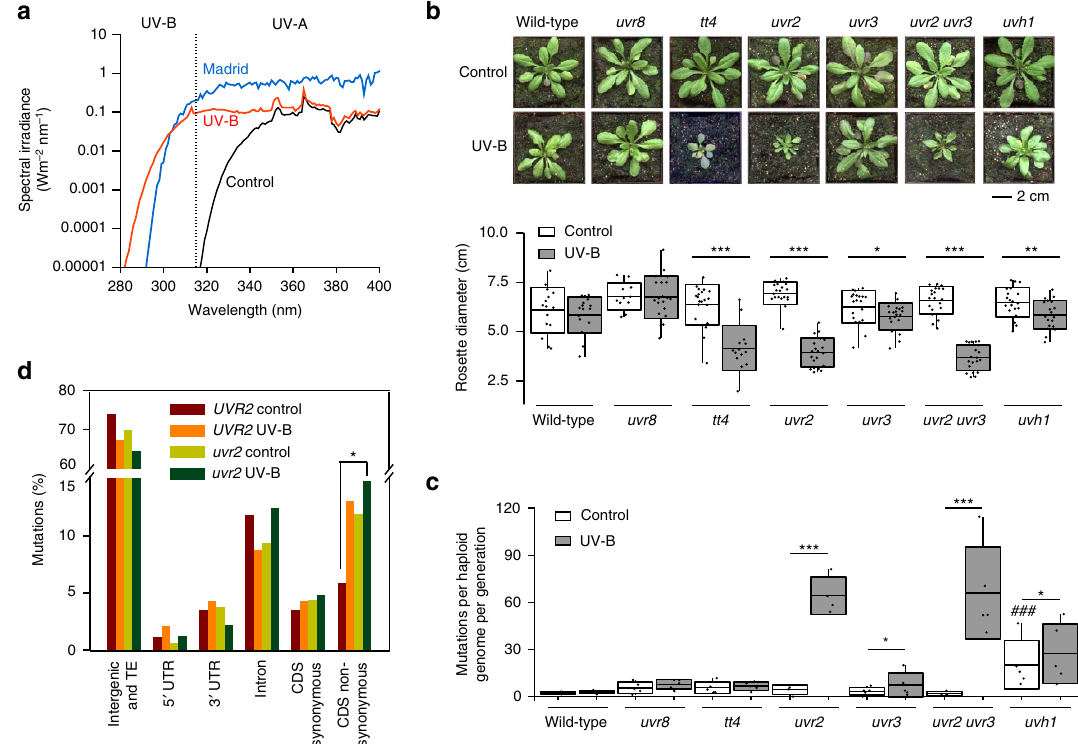
Figure 1 | Frequencies and spectra of UV-B treatment-induced mutations. ( a ) Spectral irradiance in sun simulator of the UV-B-free control (black; UV-B BE normalized at 300nm (ref. 21) ¼ 0mWm (cid:2) 2 ), and the simulated UV-B level of Madrid (red; UV-B BE normalized at 300nm (ref. 21) ¼ 300mWm (cid:2) 2 ) in UV-B and UV-A range (divided by dotted vertical line). The modelled Madrid UV-B BE (blue; UV-B BE normalized at 300nm (ref. 21) ¼ 265mWm (cid:2) 2 ) was generated using the Quick Tropospheric UV Radiation Calculator. ( b ) Representative phenotypes of individual genotypes grown under control and 300mWm (cid:2) 2 UV-B BE . Rosette diameter measurements were performed on 11–20 plants per genotype and treatment. Significant differences in Student’s t - test (* P o 0.05 , * * P o 0.01, ** * P o 0.001). ( c ) Normalized number of control and mutations induced by UV-B treatment per haploid genome and generation. Boxes show genotype average (middle line), s.d. (lower and upper margins), and values outside of the s.d. range (vertical bars). Dots represent individual genomes. ### and * indicate statistically significant (* P o 0.05, * * P o 0.01, ** * P o 0.001) differences in Fisher’s exact test between: ### mutants versus wild-type and *control versus UV-B treatments (300mWm (cid:2) 2 UV-B BE ) of the same genotype, respectively. ( d ) Frequency of non-synonymous amino-acid changes in different genomic regions. UVR2 includes Col-0, uvr8 , tt4 and uvr3 genotypes treated with 0mWm (cid:2) 2 UV-B BE (control) or with 100, 150 and Table 1. *statistically significant (* P ¼ 0.0254) difference in Fisher’s exact test. All other comparisons within groups were not significant.